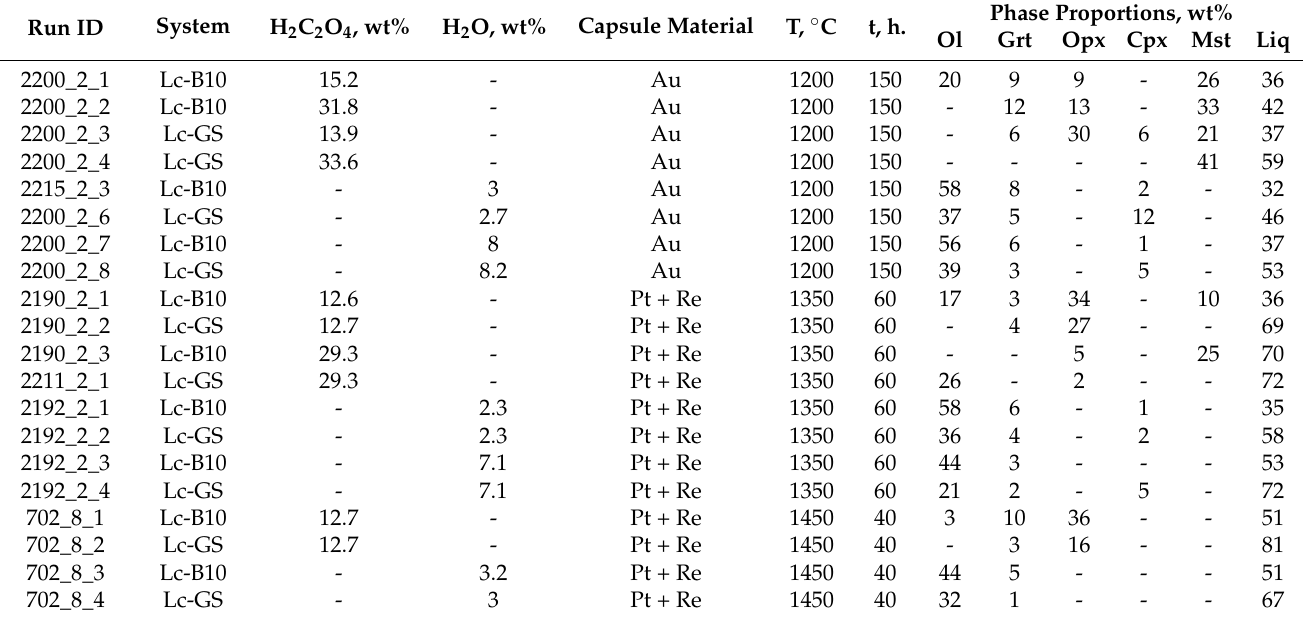
Table 2. Experimental conditions and phase composition of